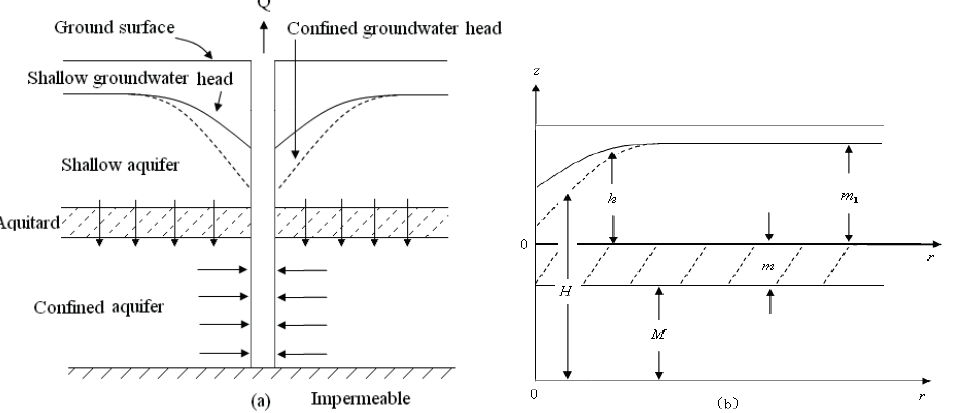
Fig. 1 Schematic of a single confined aquifer pumping well shown in vertical profile (a) and its mathematical representation